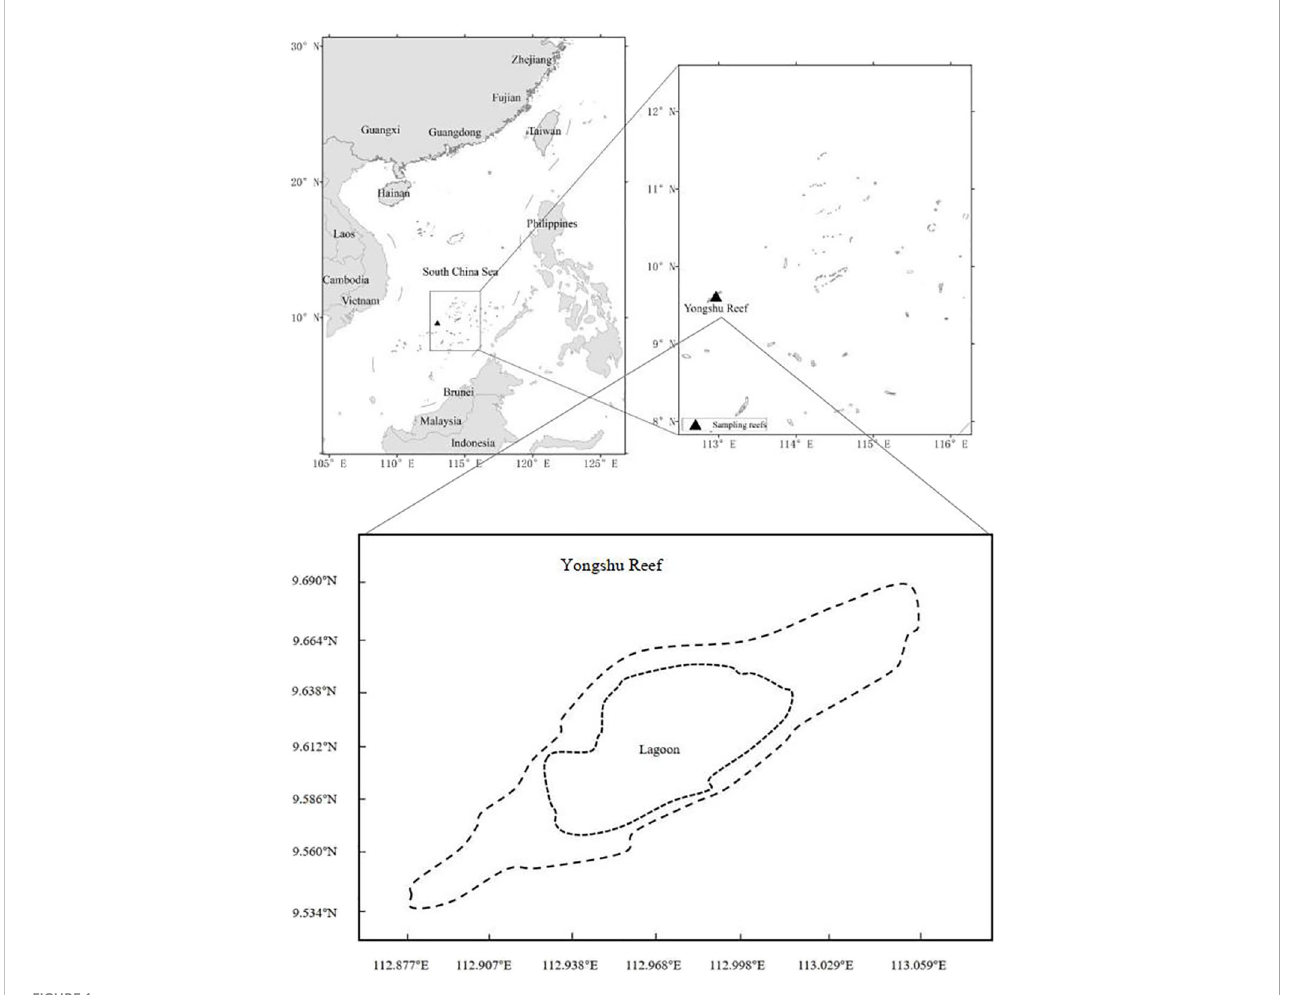
FIGURE 1 Study location: Yongshu Reef in the South China